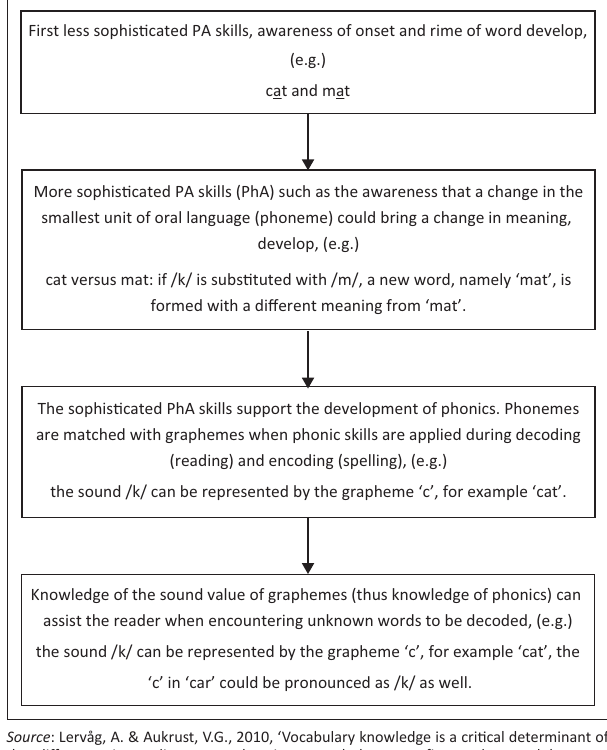
FIGURE 1: The progression of applying specific phonetic decoding skills.